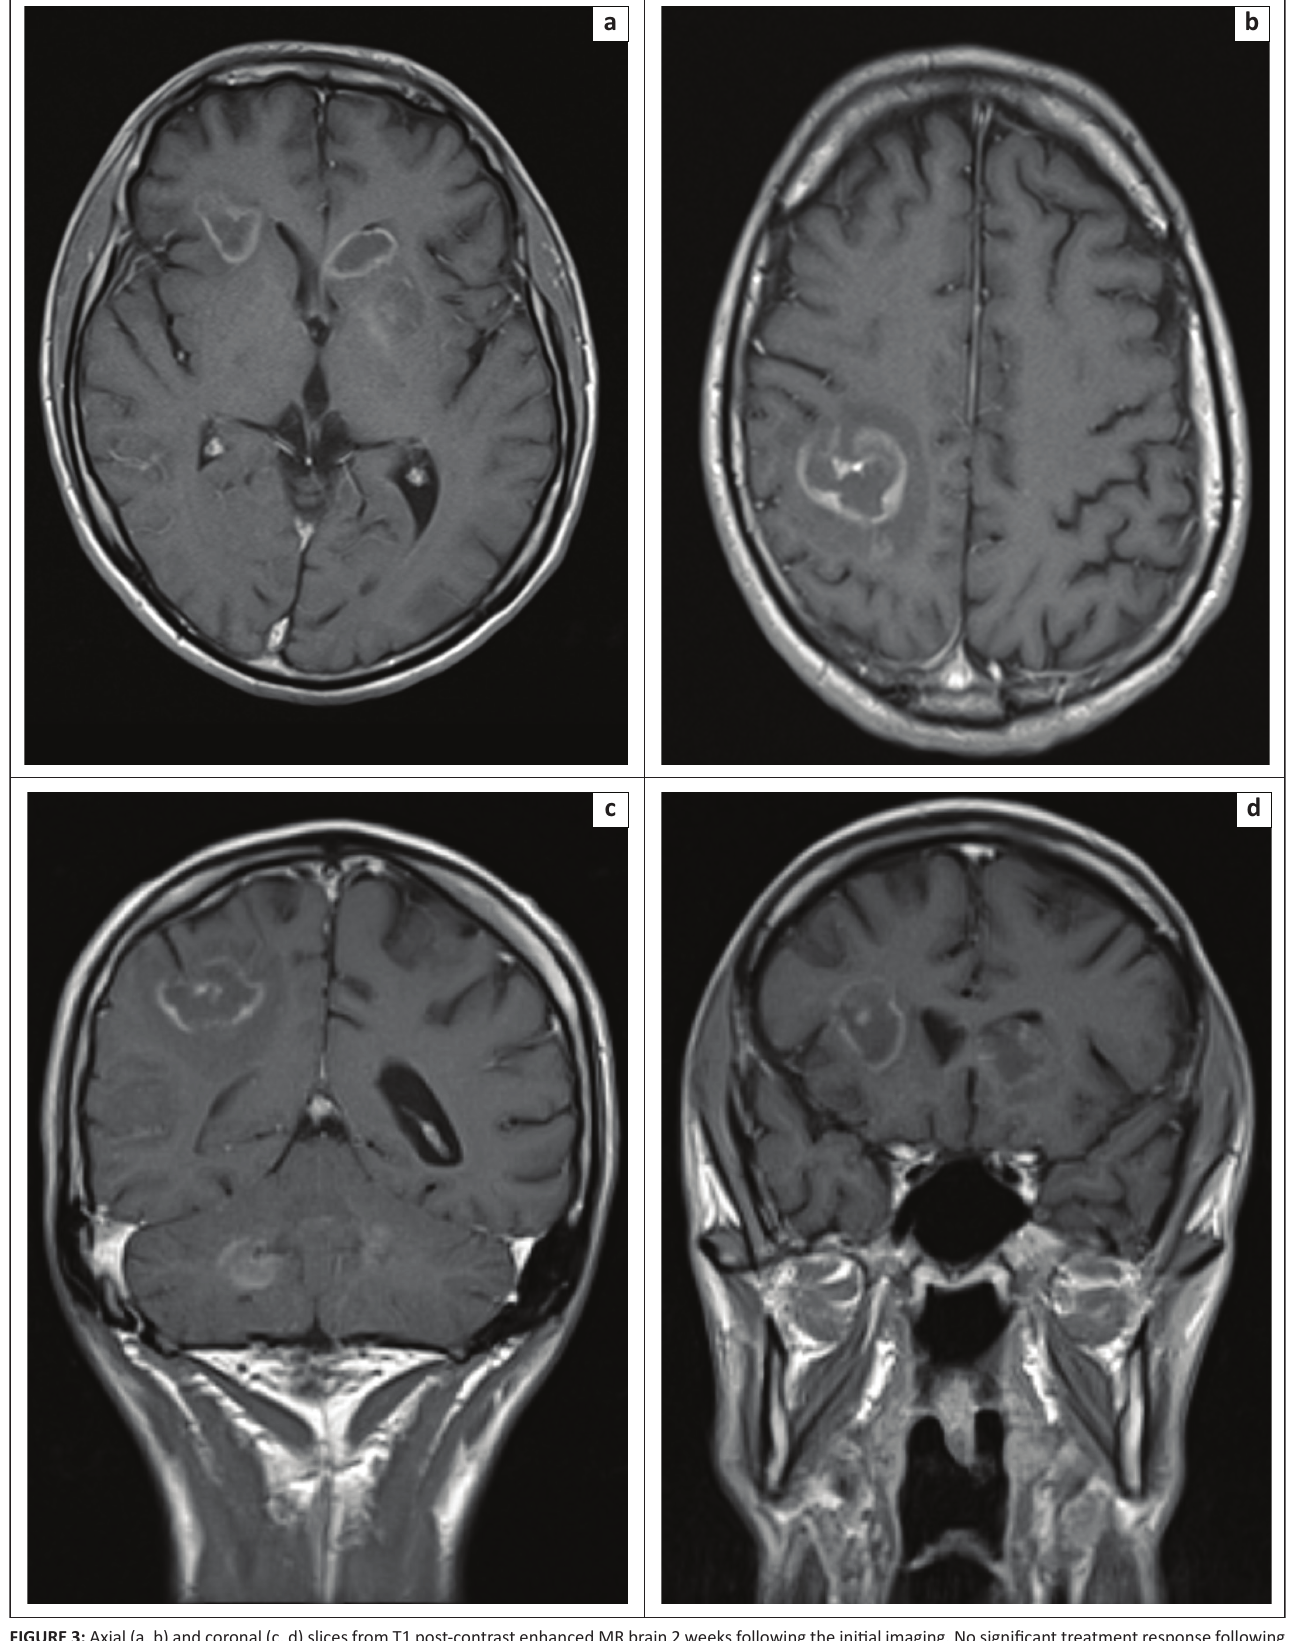
FIGURE 3: Axial (a, b) and coronal (c, d) slices from T1 post-contrast enhanced MR brain 2 weeks following the initial imaging. No significant treatment response following 2 weeks of toxoplasmosis treatment with sulfadiazine/pyramethamine/folinic acid and adjunctive high-dose dexamethasone with persistent ring-enhancing lesions identified. There was marked peri-lesional vasogenic oedema and two new lesions were seen. A few of these lesions, for example, the lesion within the head of the left caudate nucleus demonstrated restricted diffusion on diffusion weighted imaging (not demonstrated), in keeping with increased cellularity. This finding is atypical of toxoplasmosis and thus raised the suspicion for alternative diagnoses over